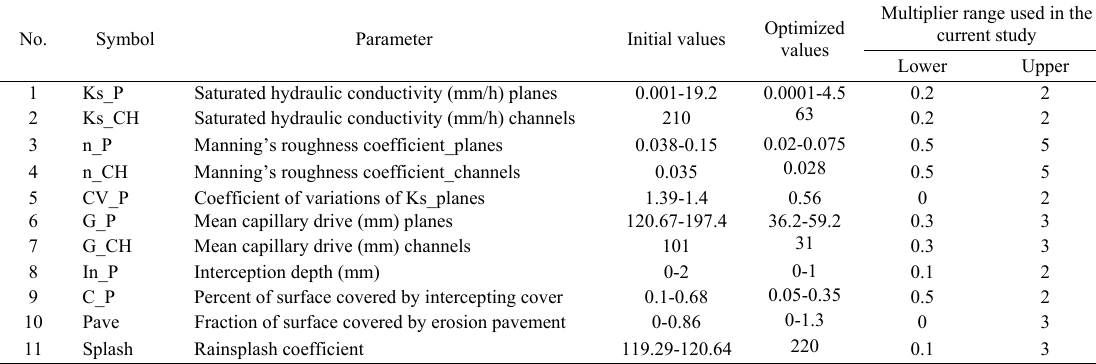
Table 2: Optimization parameters used in K2 Table 1: Characteristics of chosen rainfall